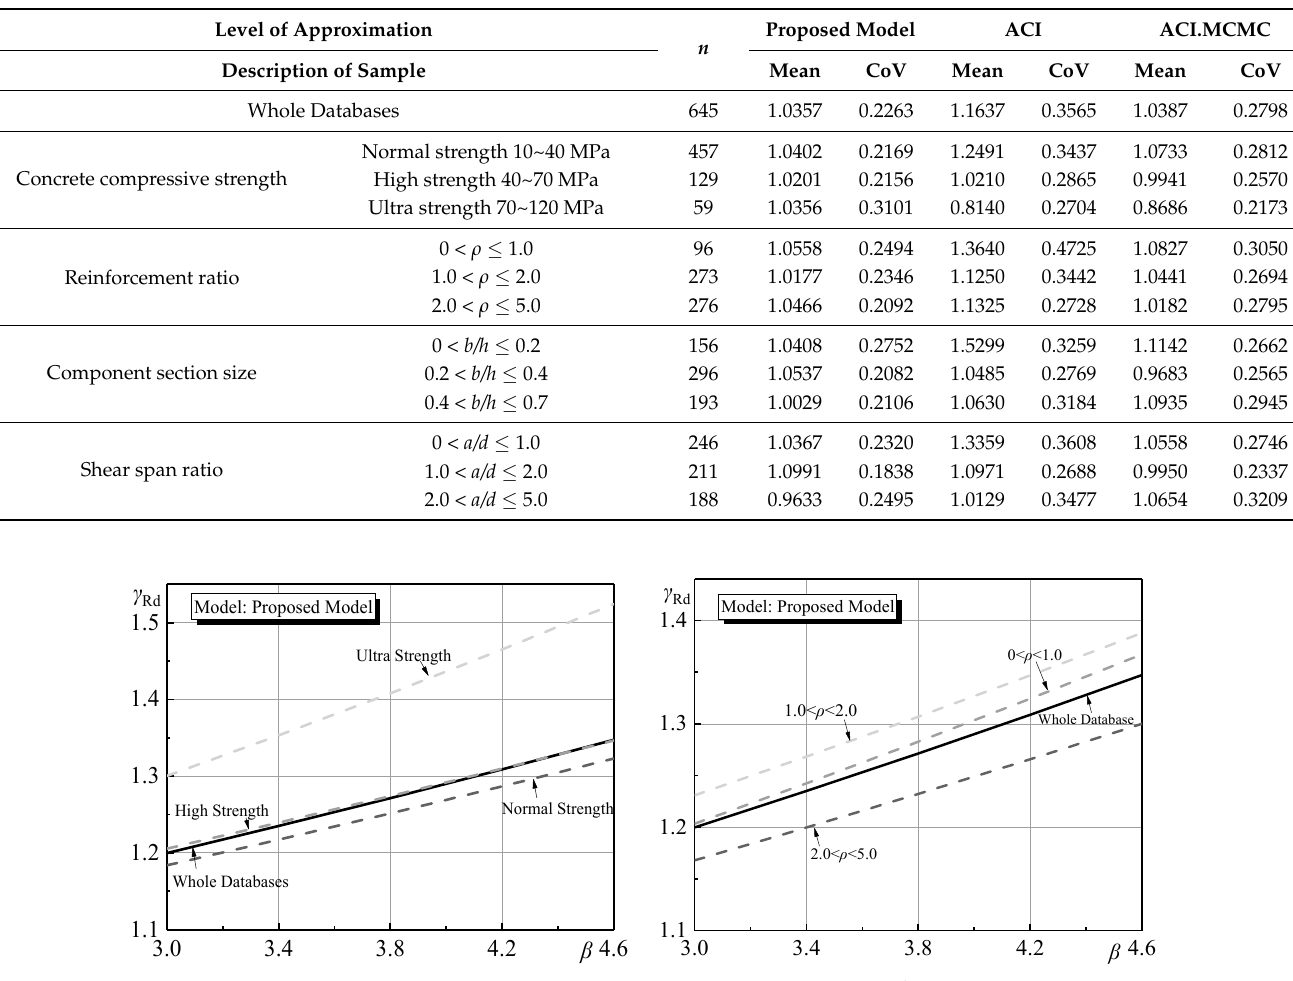
Table 7. Sample characteristics for different ranges of the key explanatory terms.